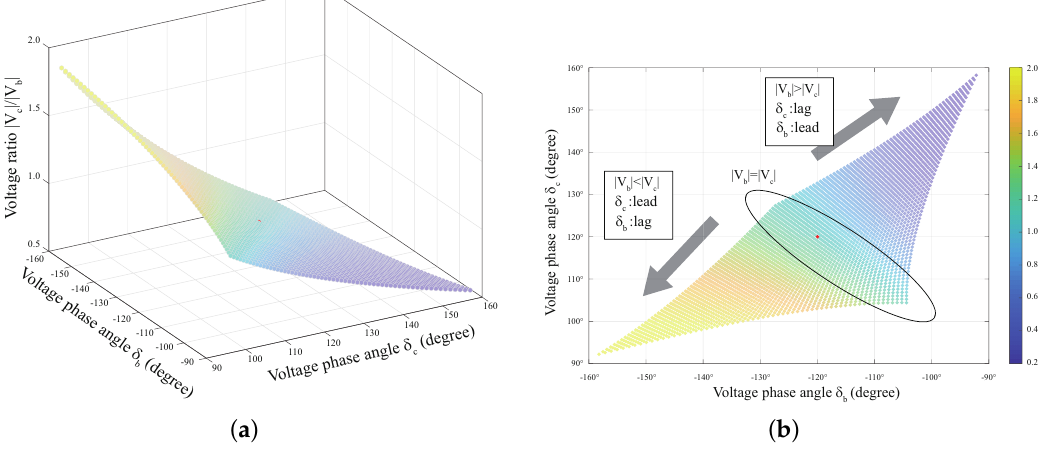
Figure 9. Undetectable unbalance points on the symmetrical component method: ( a ) 3D plot and ( b ) 2D